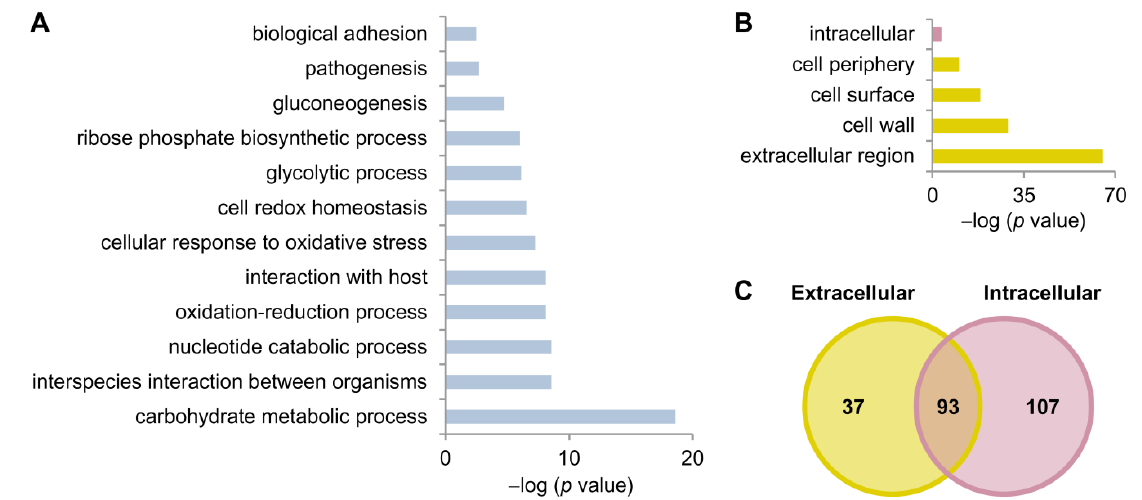
Figure 2. GO analysis of the proteins identified in both secretome batches (S1 and S2) with at least 2 peptides. ( A ) GO enrichment in biological process of the secreted proteins. ( B ) GO enrichment in cellular component of the secreted proteins. ( C ) Venn diagram showing the number of proteins annotated as extracellular and/or intracellular locations. Table 1. List of the identified proteins in both secretome batches (S1 and S2) with at least two peptides classified regard- ing their cellular location a .